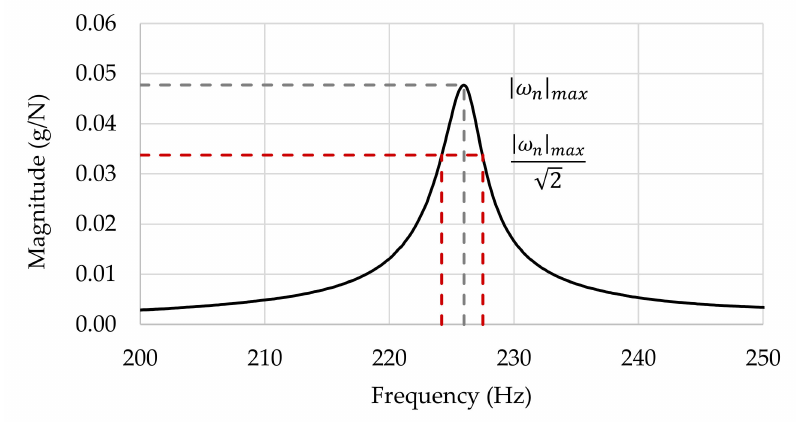
Figure 3. The logarithmic spectra of Fourier in